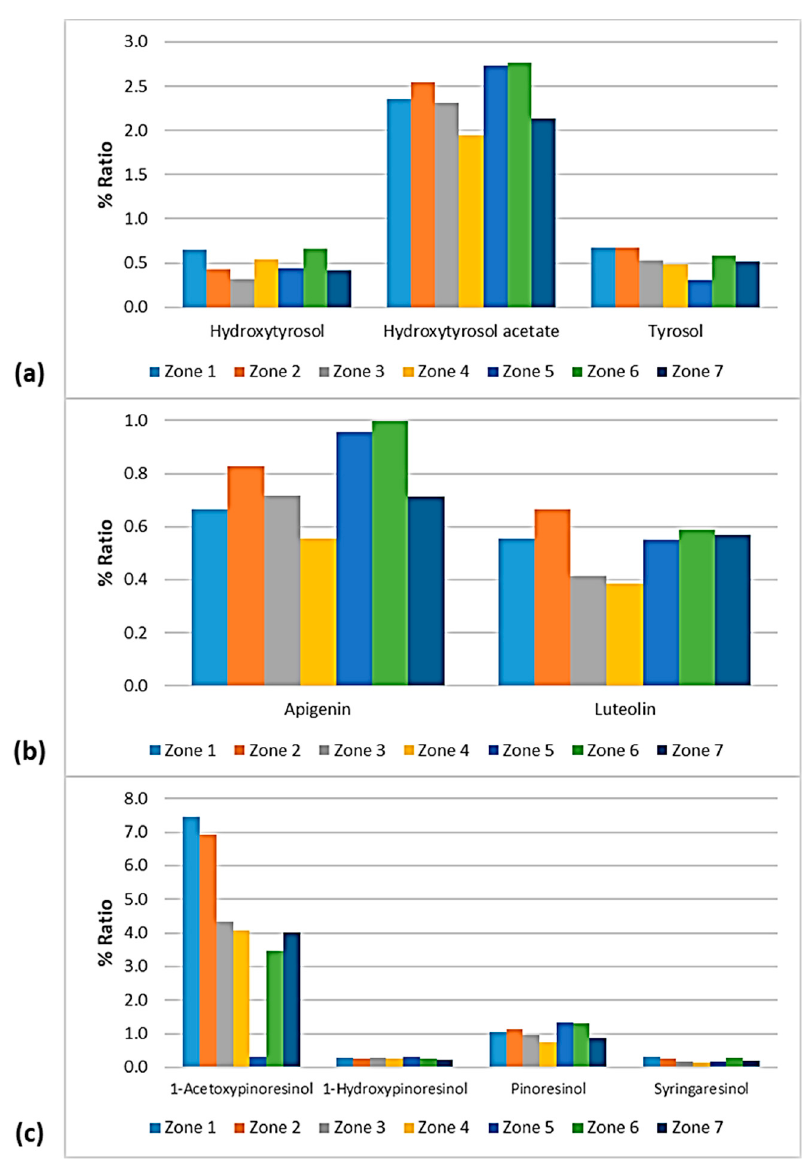
Figure 14. % Ratio of the compounds from the class of ( a ) phenolic alcohols (hydroxytyrosol, hy- droxytyrosol acetate, and tyrosol); ( b ) flavonoids (apigenin and luteolin); and ( c ) lignans (1-acetox- ypinoresinol, 1-hydroxypinoresinol, pinoresinol, and syringaresinol) to the phenolic content in the EVOOs between the zones of Lesvos (Zones 1–7).